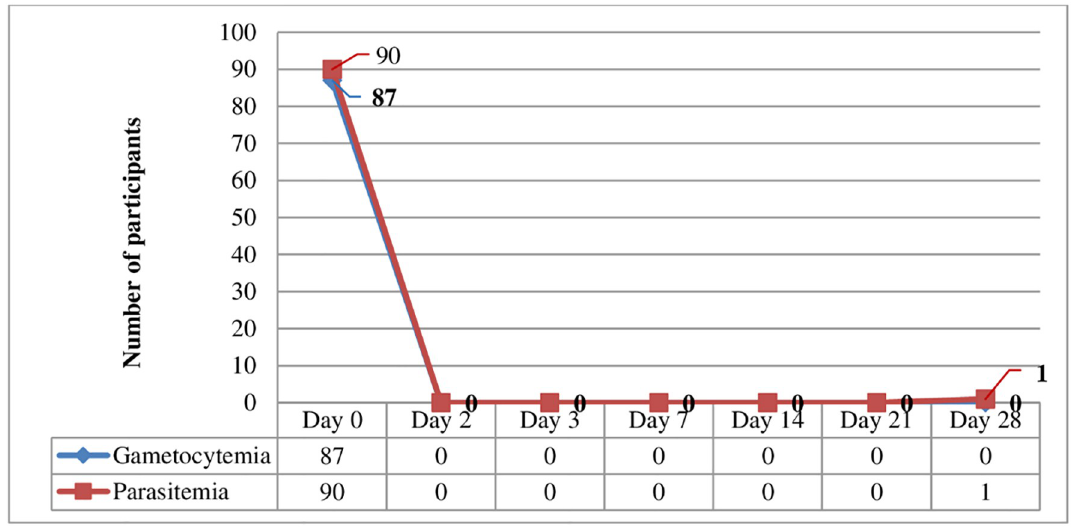
Fig 4. A pattern of parasite and gametocyte clearance following chloroquine treatment in Shewa Robit Health Centre, northeast Ethiopia from November 2020 to March 2021.